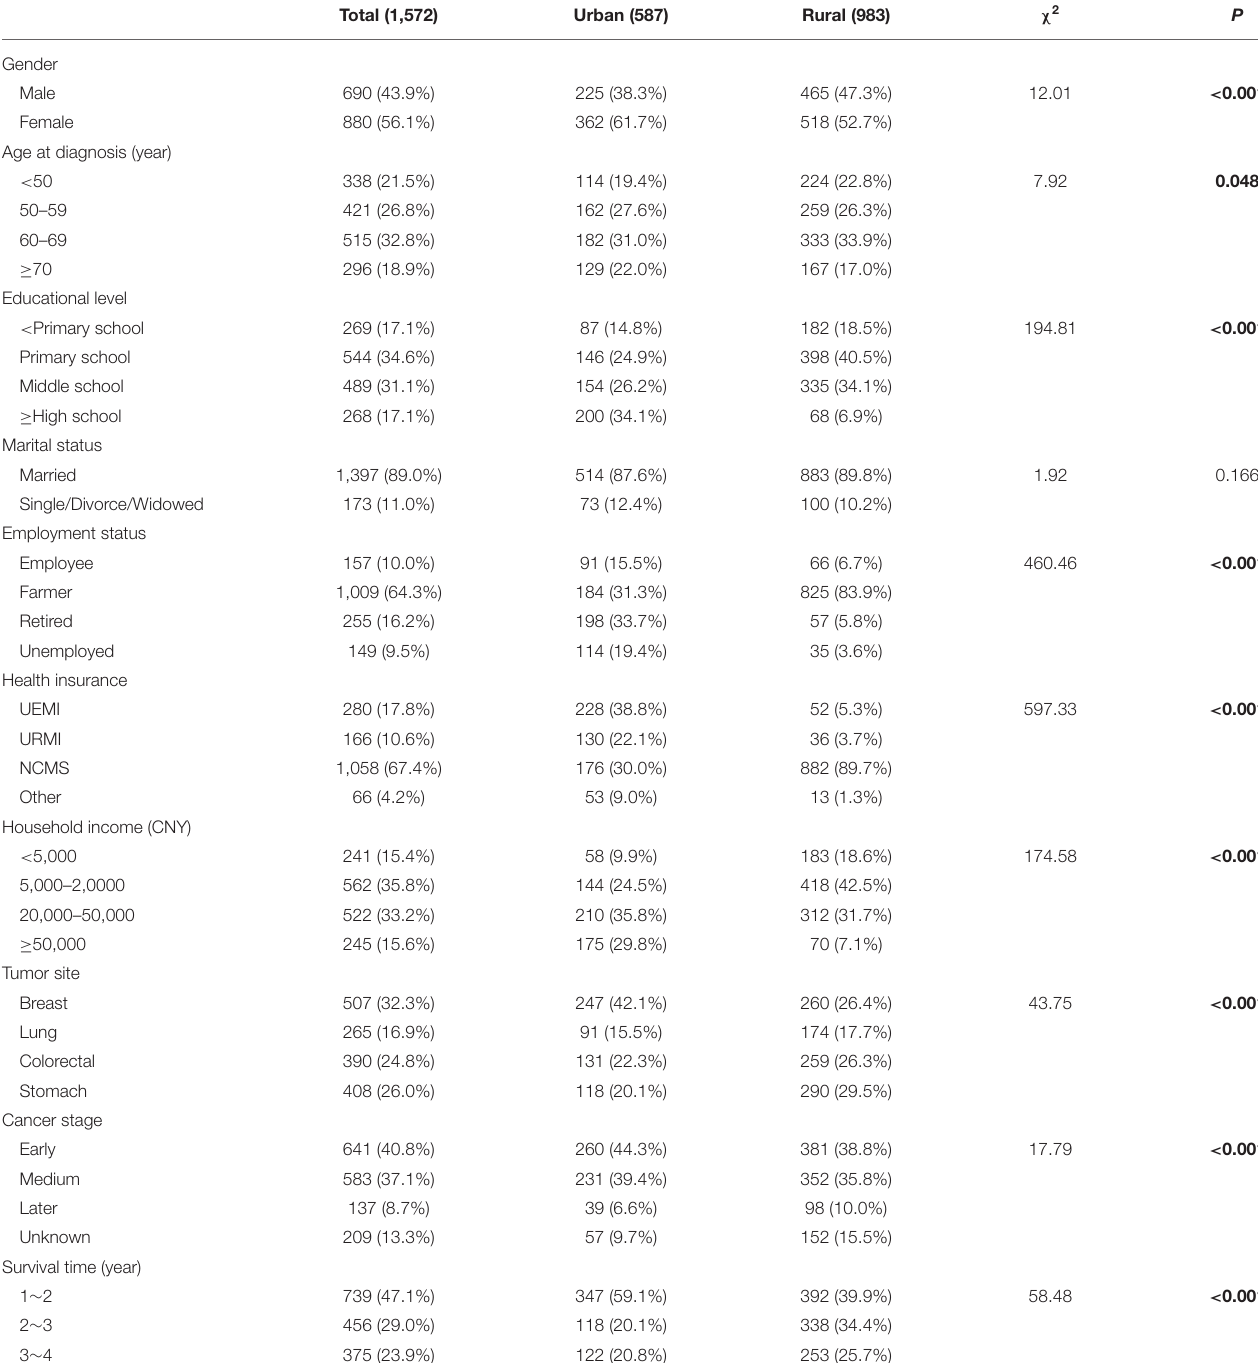
TABLE 1 | Basic characteristics of the participants and urban-rural disparities (N,